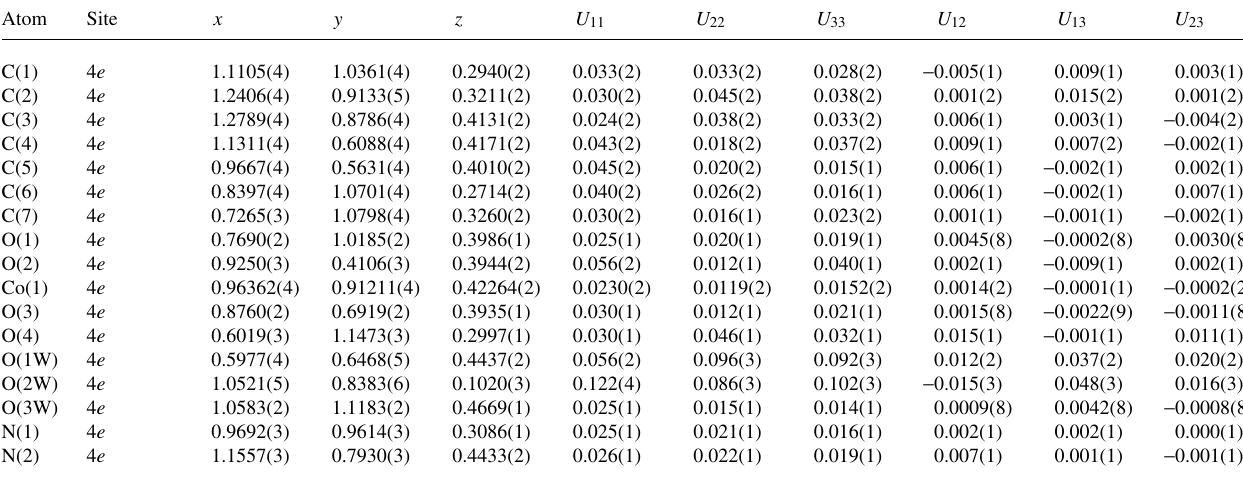
Table 3. Atomic coordinates and displacement parameters (in Å 2 )